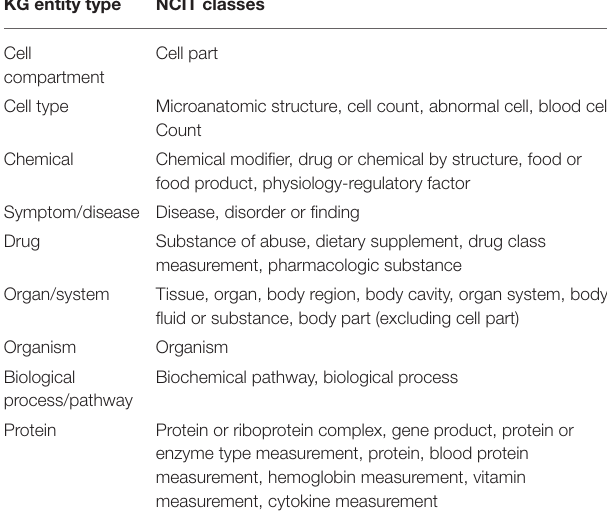
Protein Protein or riboprotein complex, gene product, protein or enzyme type measurement, protein, blood protein measurement, hemoglobin measurement, vitamin measurement, cytokine